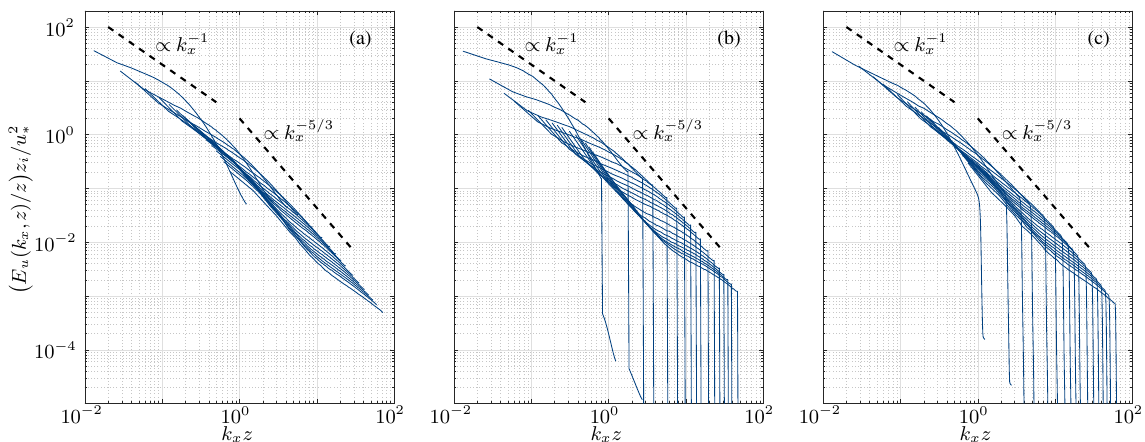
Figure 9. Normalized streamwise spectra of the streamwise velocity as a function of k x z for the 192 3 simulations. The three different dealiasing methods are the 3 / 2 rule (a) , the FT method (b) , and the FS method (c) at heights z/z i = 0 . 0117, 0 . 0273, 0 . 0586, 0 . 0898, 0 . 1523,